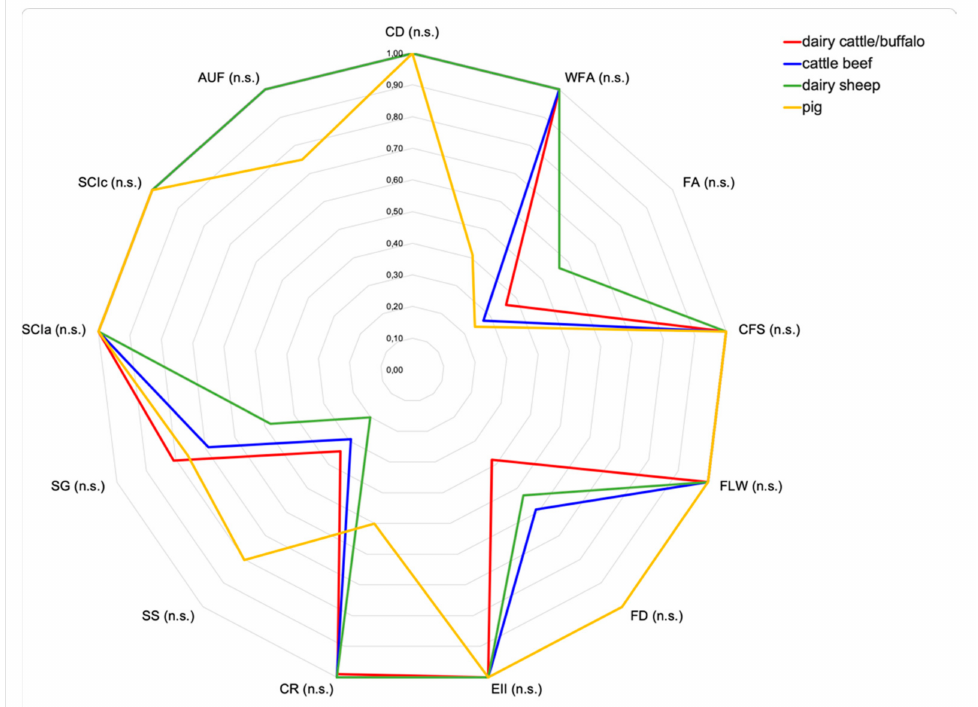
Figure 1. Discrepancy of the indicators’ values between production